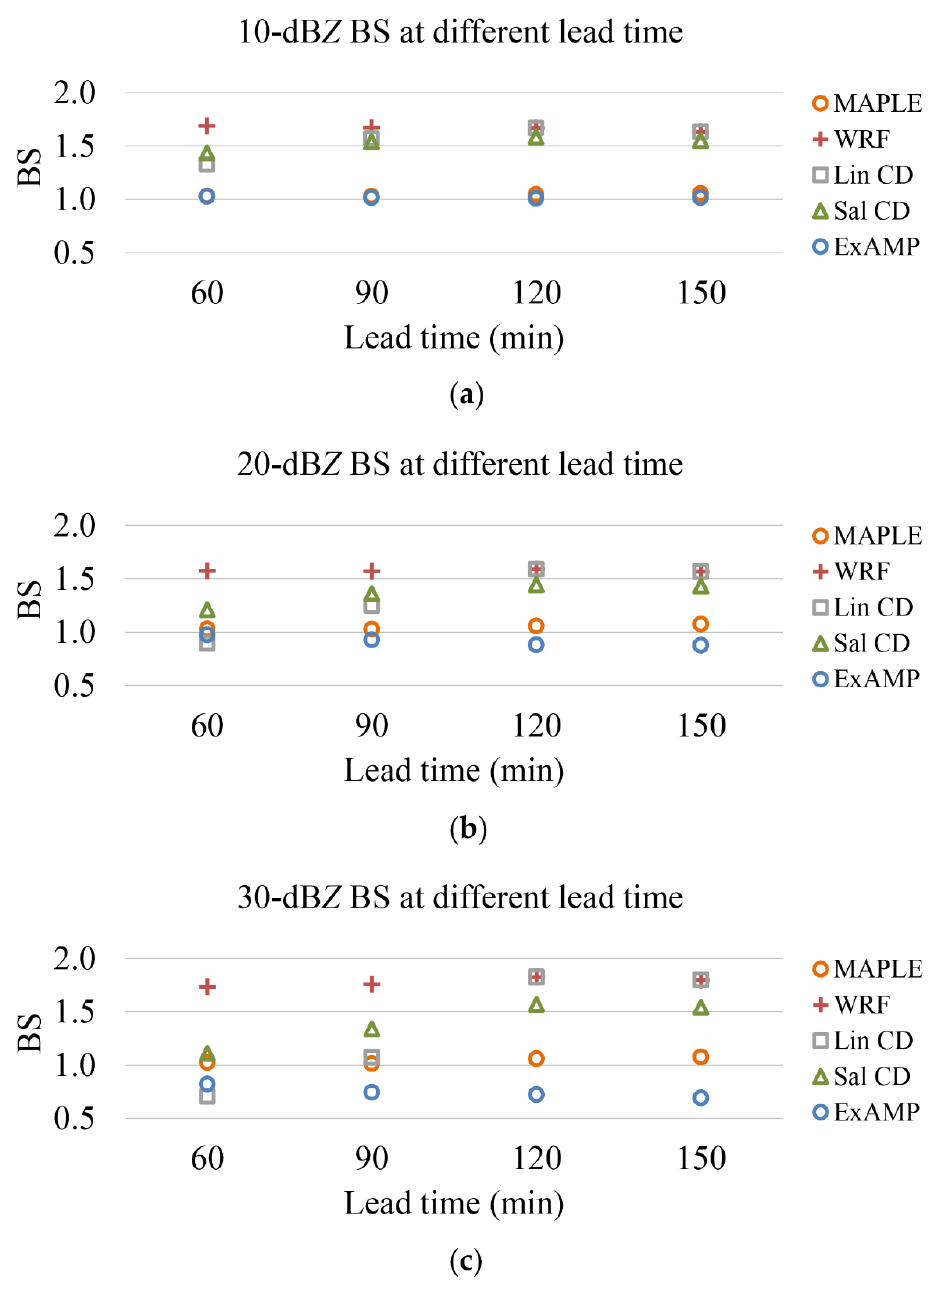
Figure 7. The bias scores (BSs) of MAPLE, WRF, Lin CD, Sal CD, and ExAMP above ( a ) 10, ( b ) 20, and ( c ) 30 dB Z thresholds at the lead times of 90, 120, and 150 min, computed over the grid points with observed reflectivity exceeding 0 dB Z for the 43 periods.